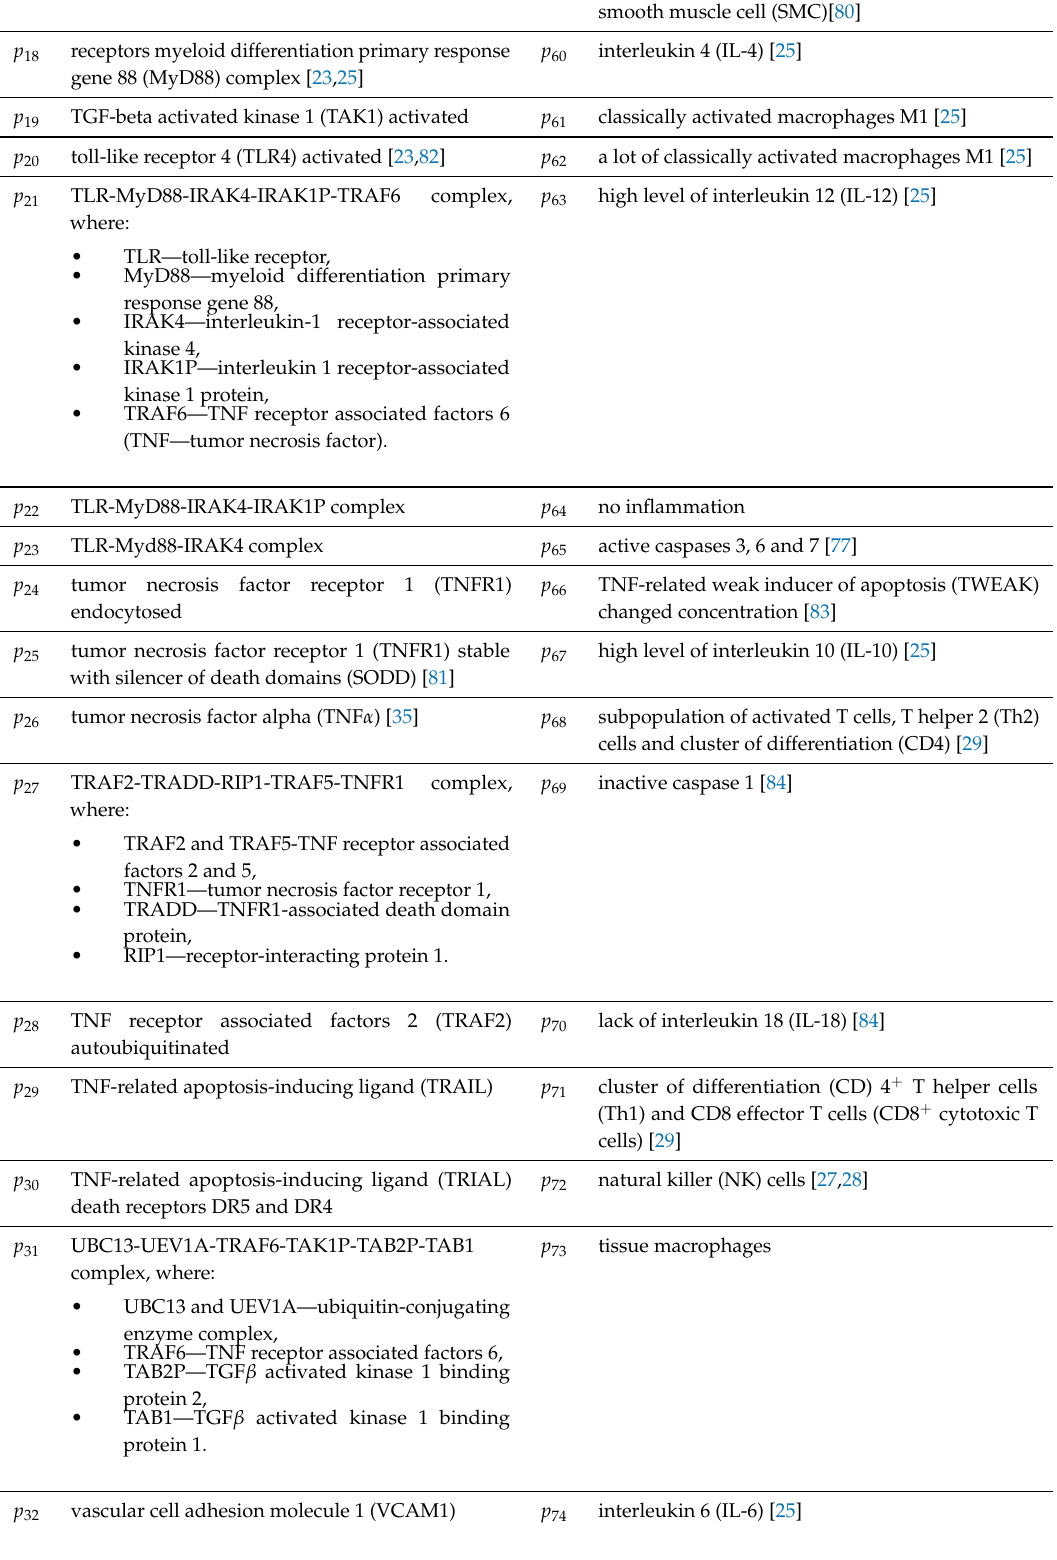
TAB2P—TGF β activated kinase 1 binding TAB1—TGF β activated kinase 1